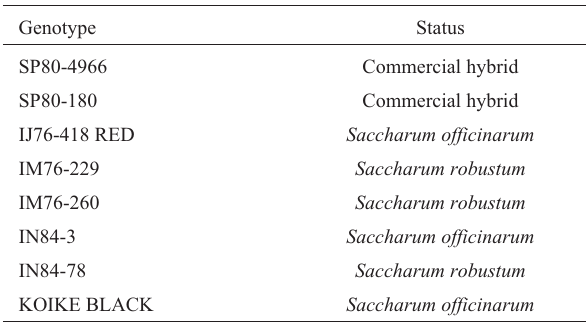
Table II - Wild and Commercial hybrid sugarcane genotypes studied with EST-SSR markers.